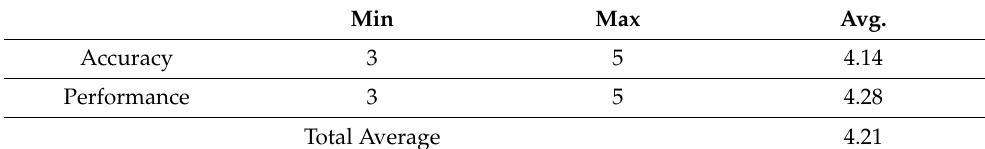
Figure 13. Distribution of responses given to questions on perceived usefulness. Table 5. Analysis results on perceived usefulness.